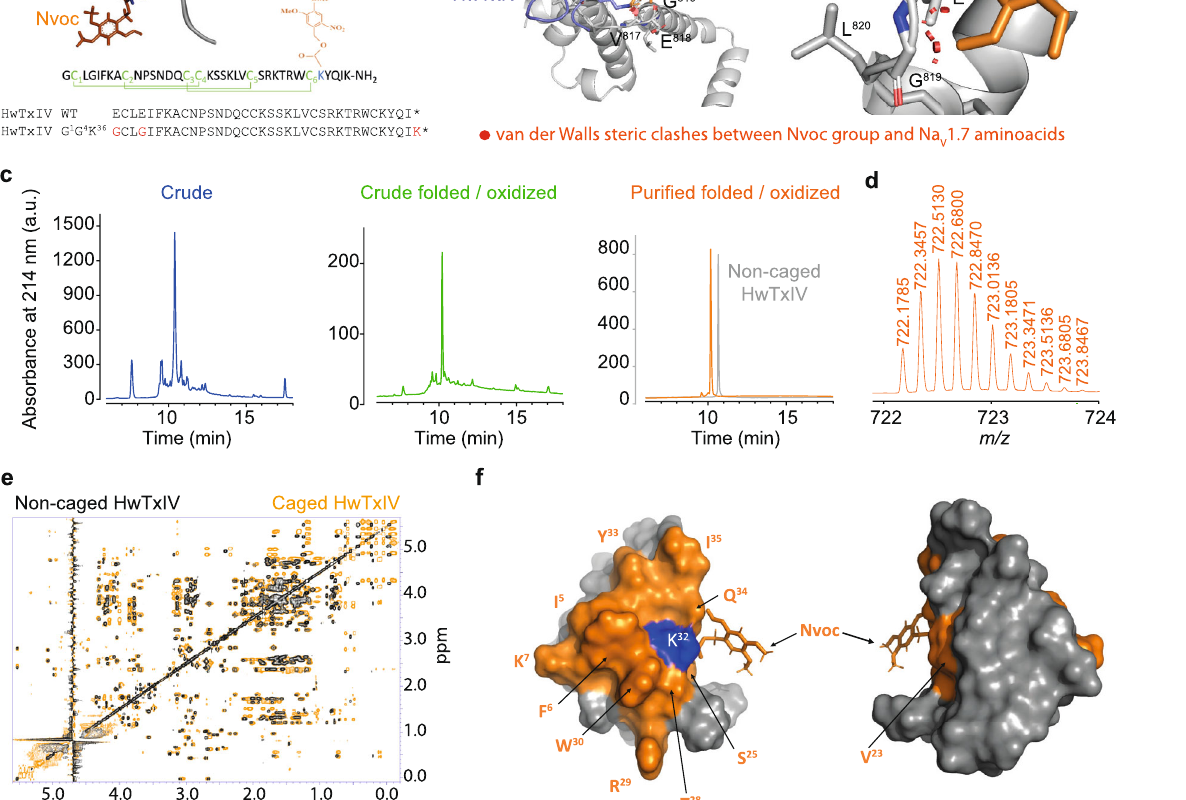
Fig. 1 Engineering of photoactivatable HwTxIV-Nvoc to modulate Na V channels. a Structure of HwTxIV-Nvoc with K 32 and Nvoc group reported in blue and orange sticks respectively. HwTxIV structure has been isolated from PDB 7K48. The sequence chosen for caging is shown upon sequence alignment with nHwTxIV. b Illustration of steric van der Walls clashes (red cylinders) resulting from the addition of the Nvoc protecting group onto K 32 upon binding of HwTxIV onto the chimeric Na v 1.7-Na v Ab in the position as published 30 (PDB code 7K48). c RP-HPLC elution pro fi les of crude, crude folded/oxidized, and puri fi ed folded/oxidized HwTxIV-Nvoc. RP-HPLC elution pro fi le of puri fi ed folded/oxidized non-caged HwTxIV has been superimposed for comparison. d LC-ESI QTOF analysis of HwTxIV-Nvoc denotes an exact mass of 722.1785 [M + 6H] 6 + . e Superimposition of TOCSY spectra (sidechains area only for clarity) of the non-caged HwTxIV (in black), and of HwTxIV-Nvoc before illumination (in orange). f Residues showing major chemical shifts modi fi cations in the presence of Nvoc are reported in orange on the surface of the molecule (180°views). K 32 is highlighted in blue. The Nvoc group is reported in sticks. Source data are provided as a Source Data